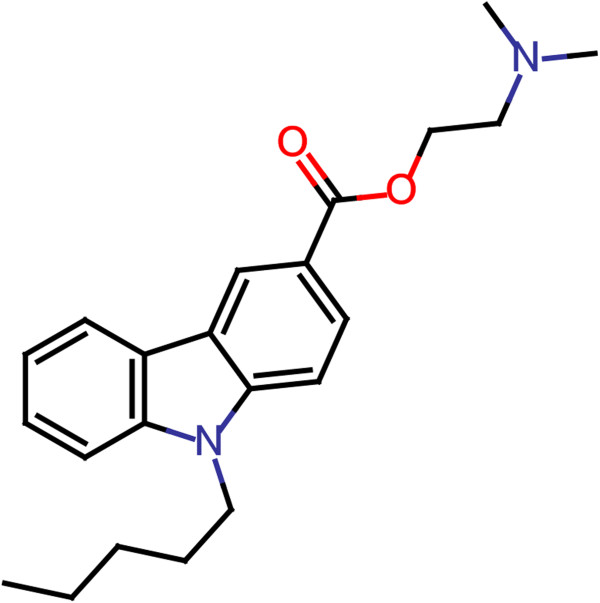
Molecular Structure of NMP-181.